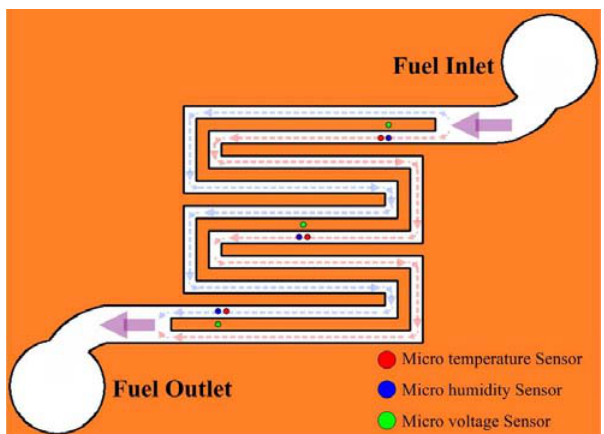
Figure 11. Locations of micro